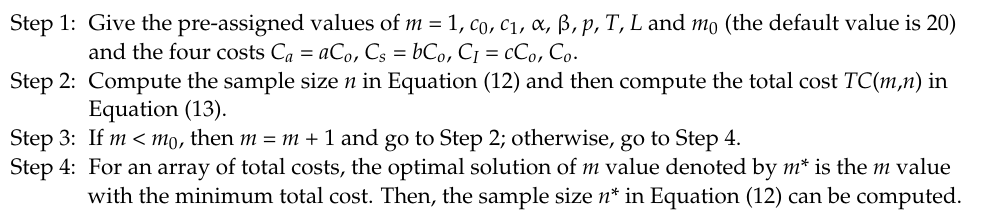
Algorithm 1: Search the optimal ( m , n )